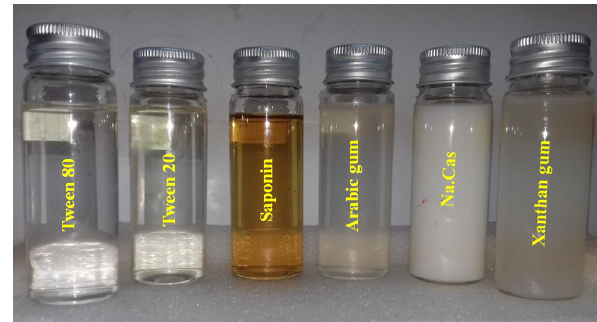
Figure 3: Appearance ( color and turbidity ) of the prepared thyme nanoemulsions using six di ff erent emulsi fi ers.